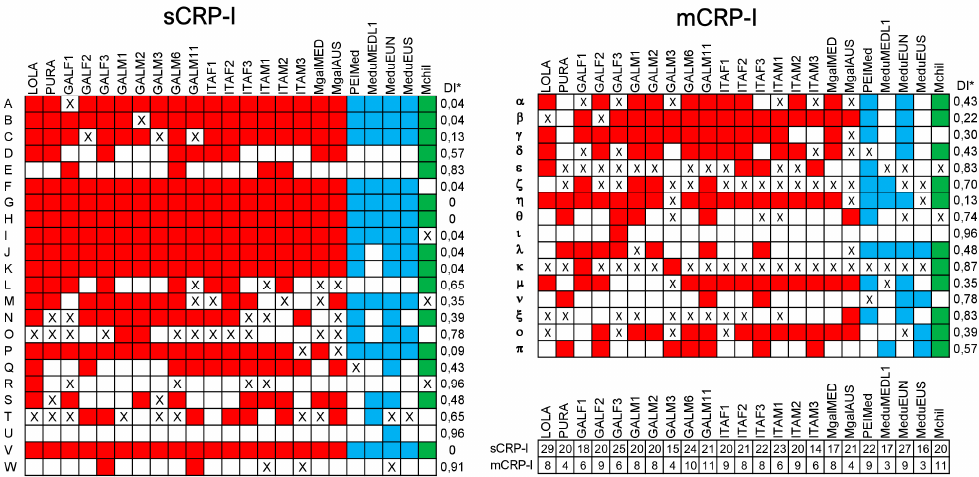
Figure 5. Patterns of gene presence/absence variation for complete and potentially functional sCRP-I and mCRP-I genes (i.e., excluding pseudogenes) in different sequenced individuals of M. galloprovincialis (red), M. edulis (blue) and M. chilensis (green). See Section 2 for a detailed description of the analyzed individuals. Colored and white boxes indicate the presence, or the absence of a given sequence group in each individual. “X” marks the identification of a pseudogene (but no functional gene) belonging to a given sequence group. A table summarizes the total number of unique complete sCRP-I and mCRP-I genes identified in each individual. * DI: dispensability index, which indicates the fraction of analyzed individuals where any given sequence group was absent.